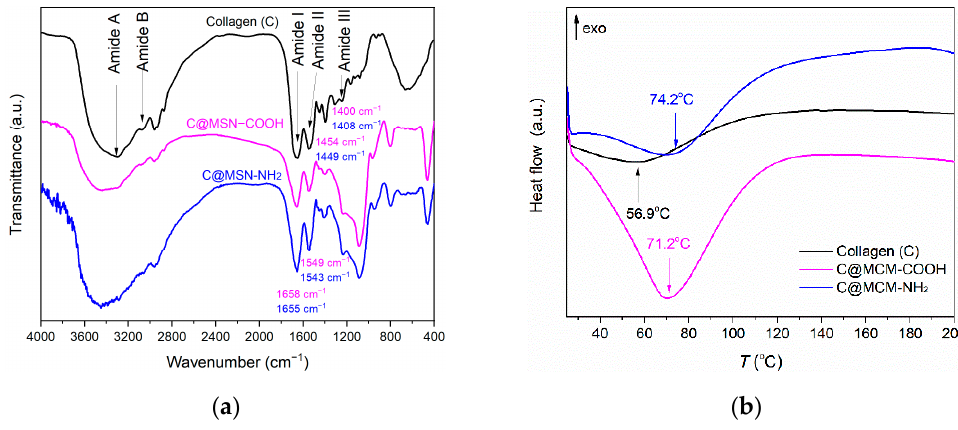
Figure 9. FTIR spectra ( a ) and DSC analysis ( b ) of collagen − MSN composites.